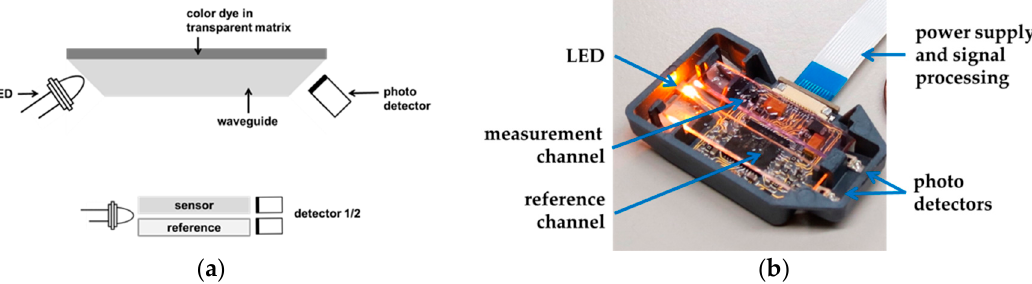
Figure 2. ( a ) Sketch of the gasochromic sensor, consisting of a planar optical waveguide, covered with the colorimetric film. The light of an LED is coupled into one end of the waveguide, and travels through it under TIR before it is focused onto a photo detector. The gas reaction leads to changes in the detector signal. Top view of the sensor element consisting of the measurement channel, a reference channel, two photo detectors, and one LED; ( b ) Picture of the waveguide-based measurement system realized by R2R processing [13].